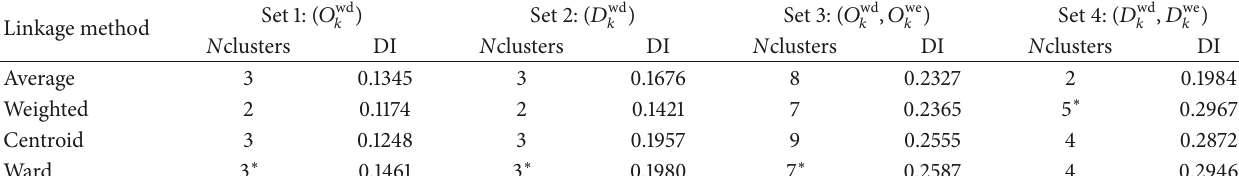
Table 1: Number of clusters and Dunn’s index (DI) obtained from each linkage method for the cases.